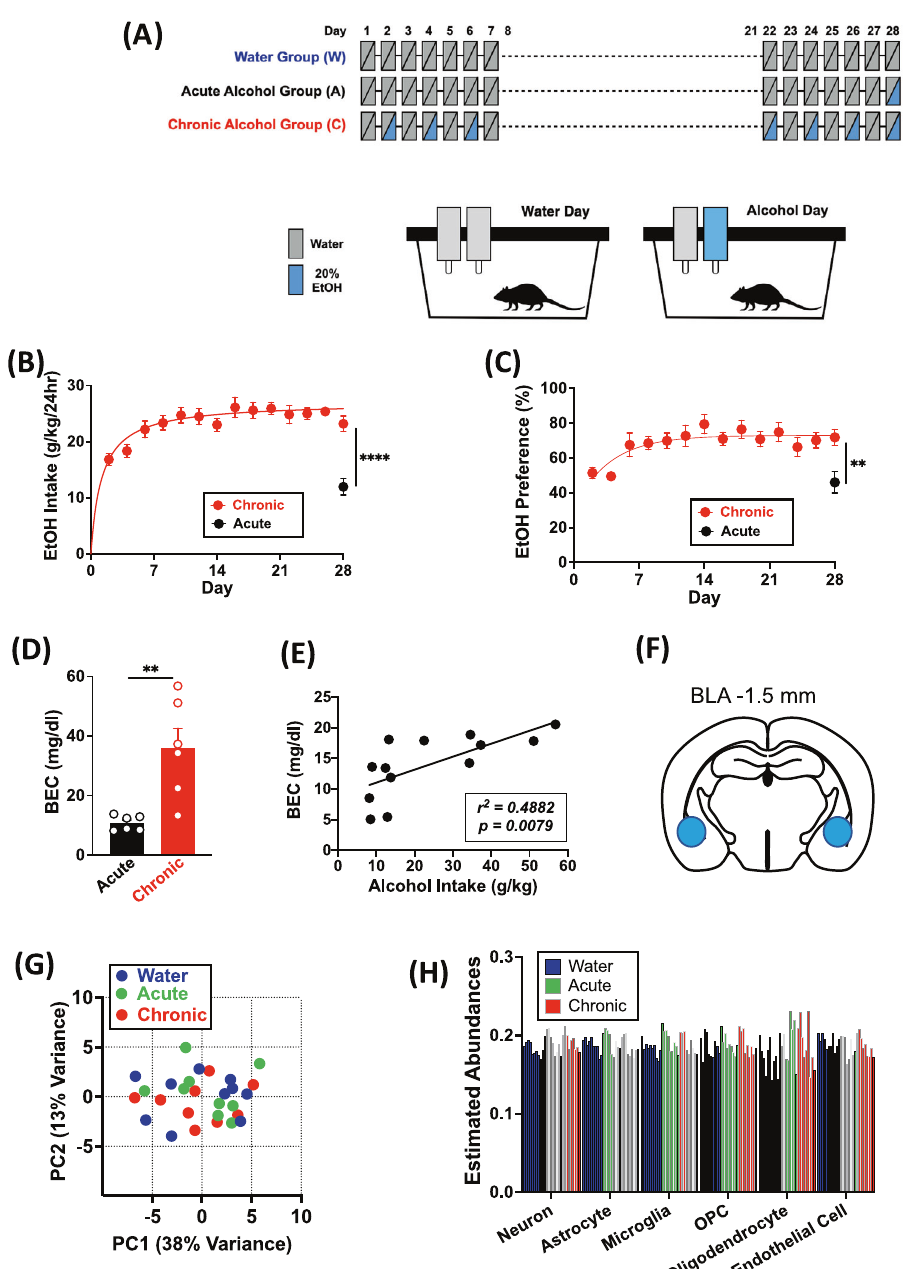
Fig. 1 Experimental design, fl uid consumption levels, and initial assessment of sequencing results. A Experimental design and timeline. B Ethanol intake over 24 h on water/20% EtOH drinking days. C EtOH preference ratios. D BEC measured in Acute and Chronic Drinking groups of 2nd cohort of mice on Day 28. E Correlation of BEC to the amount of ethanol consumed by mice in Acute and Chronic Drinking groups on Day 28. Data are mean ± SEM. ** p < 0.01 and **** p < 0.0001 difference between groups. F Diagram for amygdala tissue collection. G PCA plot showing no separation on alcohol drinking condition over the fi rst two principal components. H Bar graphs showing the estimated cell type abundance for seven relevant cell types as determined by cell type deconvolution analysis. Each bar represents a single